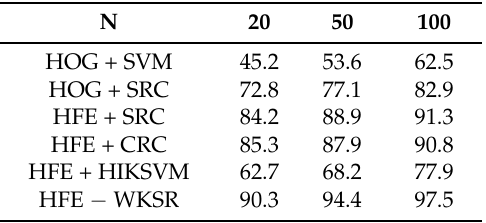
Table 3. Classification results for INRIA database.